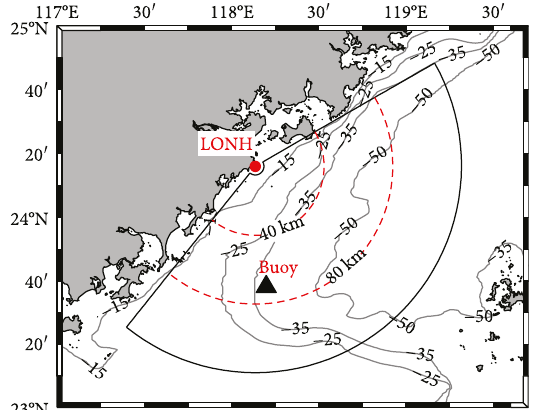
Figure 6: Map of the deployment of the radar (red dot) and the buoy (black triangle). The buoy is at a distance about 75km from the radar site. The gray thin lines are the isobaths. The fanwise area denotes the radar detection